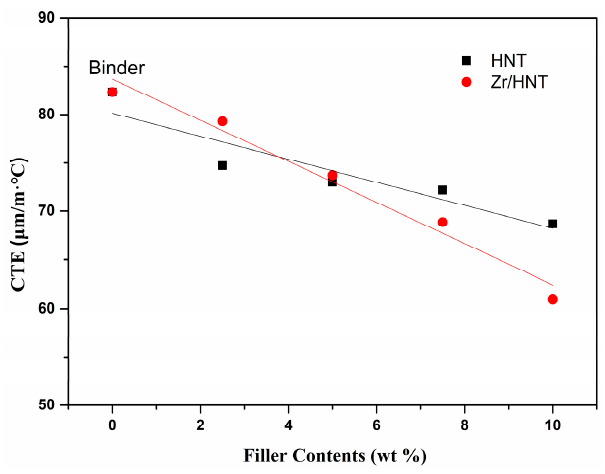
Figure 9. CTE of epoxy composites with different fillers and filler contents.